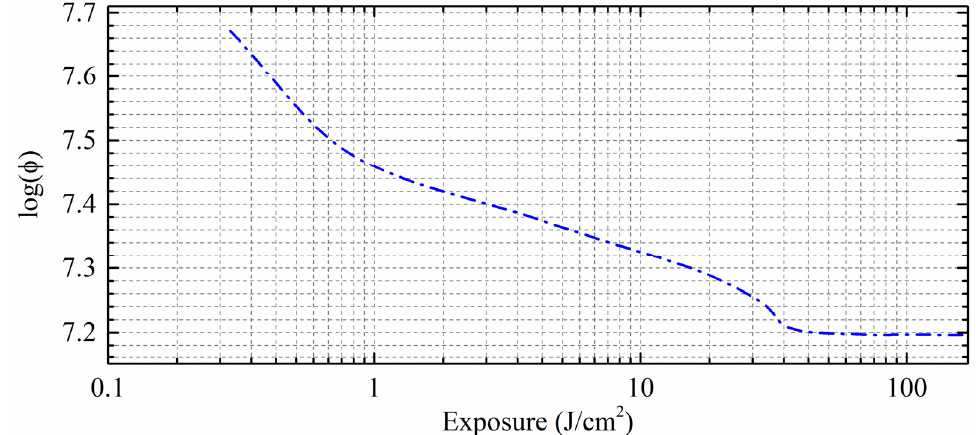
Figure 8. Reflected intensities ( log( ϕ ) ) from EBT3 films versus UV exposures.